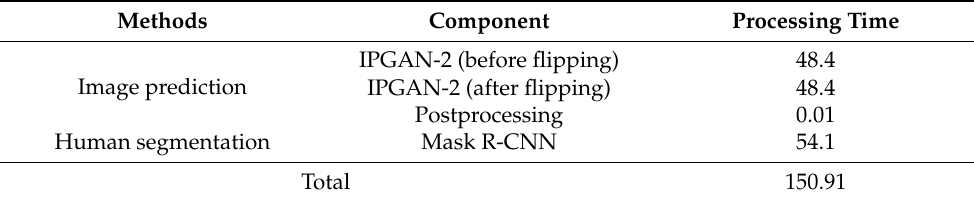
Table 16. Processing time of the proposed method per image (unit: ms).